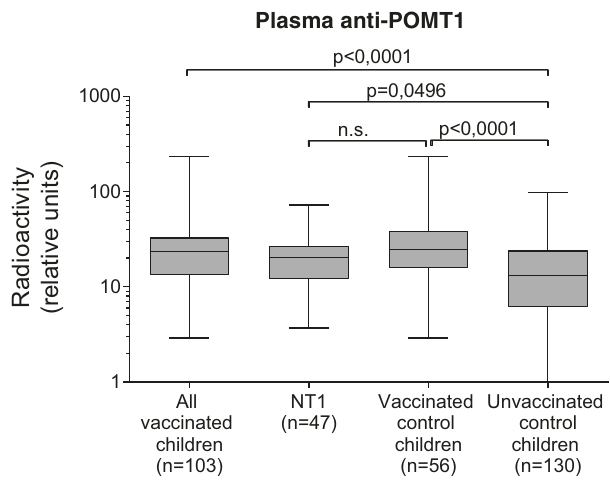
Fig. 10 Autoantibodies in Pandemrix-associated NT1. Plasma from pediatric Pandemrix-associated NT1 patients (NT1) or pediatric Pandemrix- vaccinated or unvaccinated healthy controls were analyzed by POMT1 radioimmunoassay. Radioactivity is expressed in relative units (RU). The medians (line in box), 75 and 25% quartiles (upper and lower box boundaries) and maxima/minima (upper and lower whiskers) of each group are displayed. Statistical comparisons between groups were performed, using Kruskal – Wallis and Dunn ’ s multiple comparisons